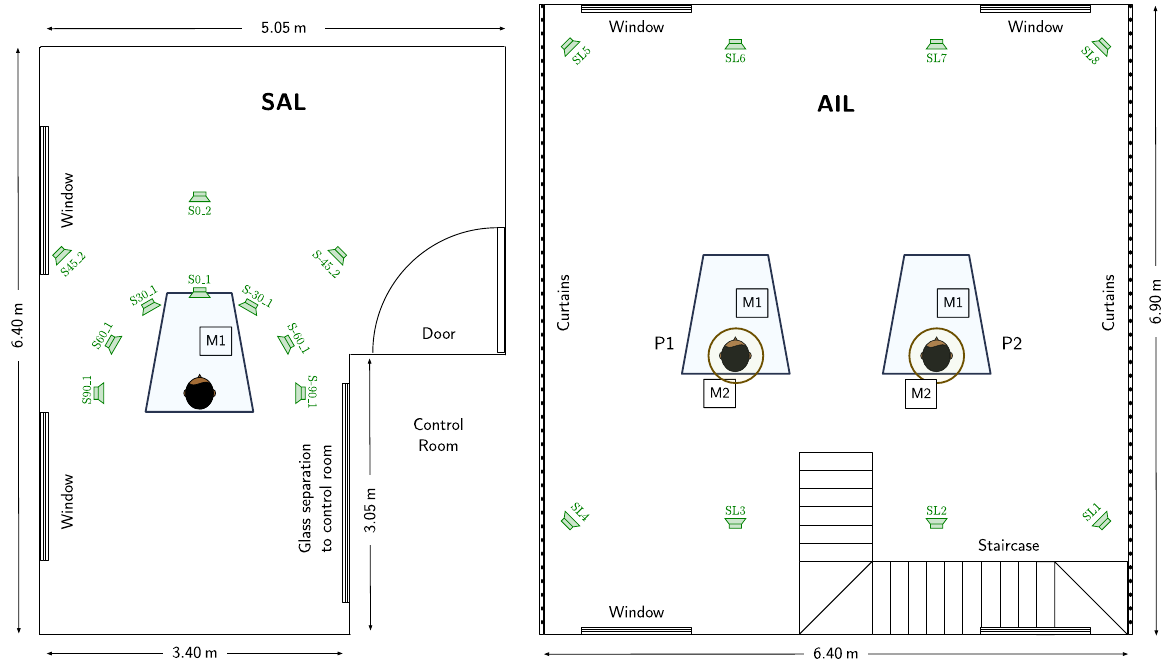
Fig. 6 Microphone and loudspeaker configuration placement. (Left) Placement of the M1 microphone configuration and the LS-SAL loudspeaker configuration within the SAL. (Right) Placement of the M1 and M2 microphone configurations in P1 and P2 as well as the lower level of the LS-AIL loudspeaker configuration within the AIL. Details of the M1 and M2 microphone configurations and the LS-SAL and LS-AIL loudspeaker configuration can be seen in Figs. 3, 4, and 5. For extracting the coordinates of the microphone and loudspeaker positions, the MATLAB or Python scripts discussed in Section 6.2 should be used